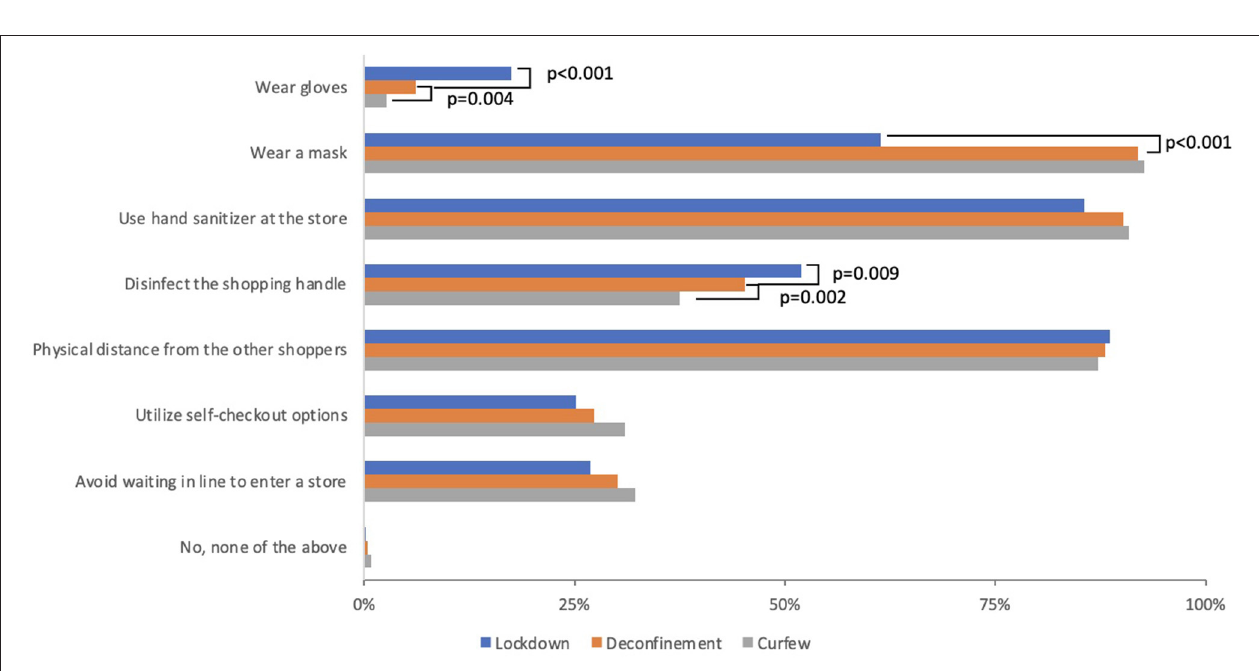
FIGURE 4 | In-store virus exposure mitigation behaviors. “When shopping for groceries in a store did you... (Check boxes if YES and select all that apply).” McNemar test comparing Lockdown (blue) to Deconfinement (orange), and Deconfinement (orange) to Curfew